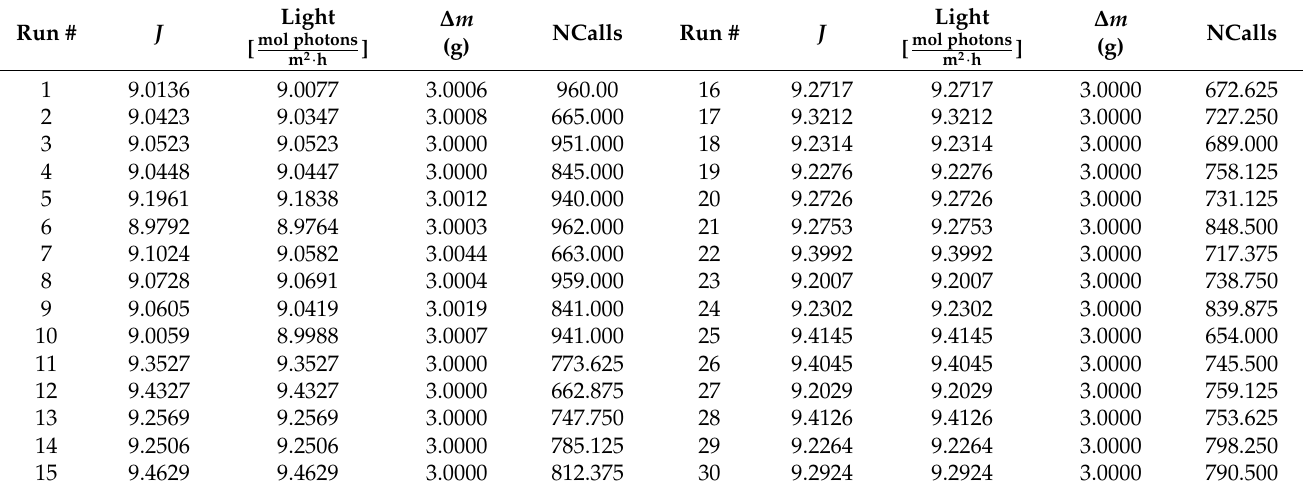
Table 6. Simulation series for RHC_Closed_Loop without SENSOR.